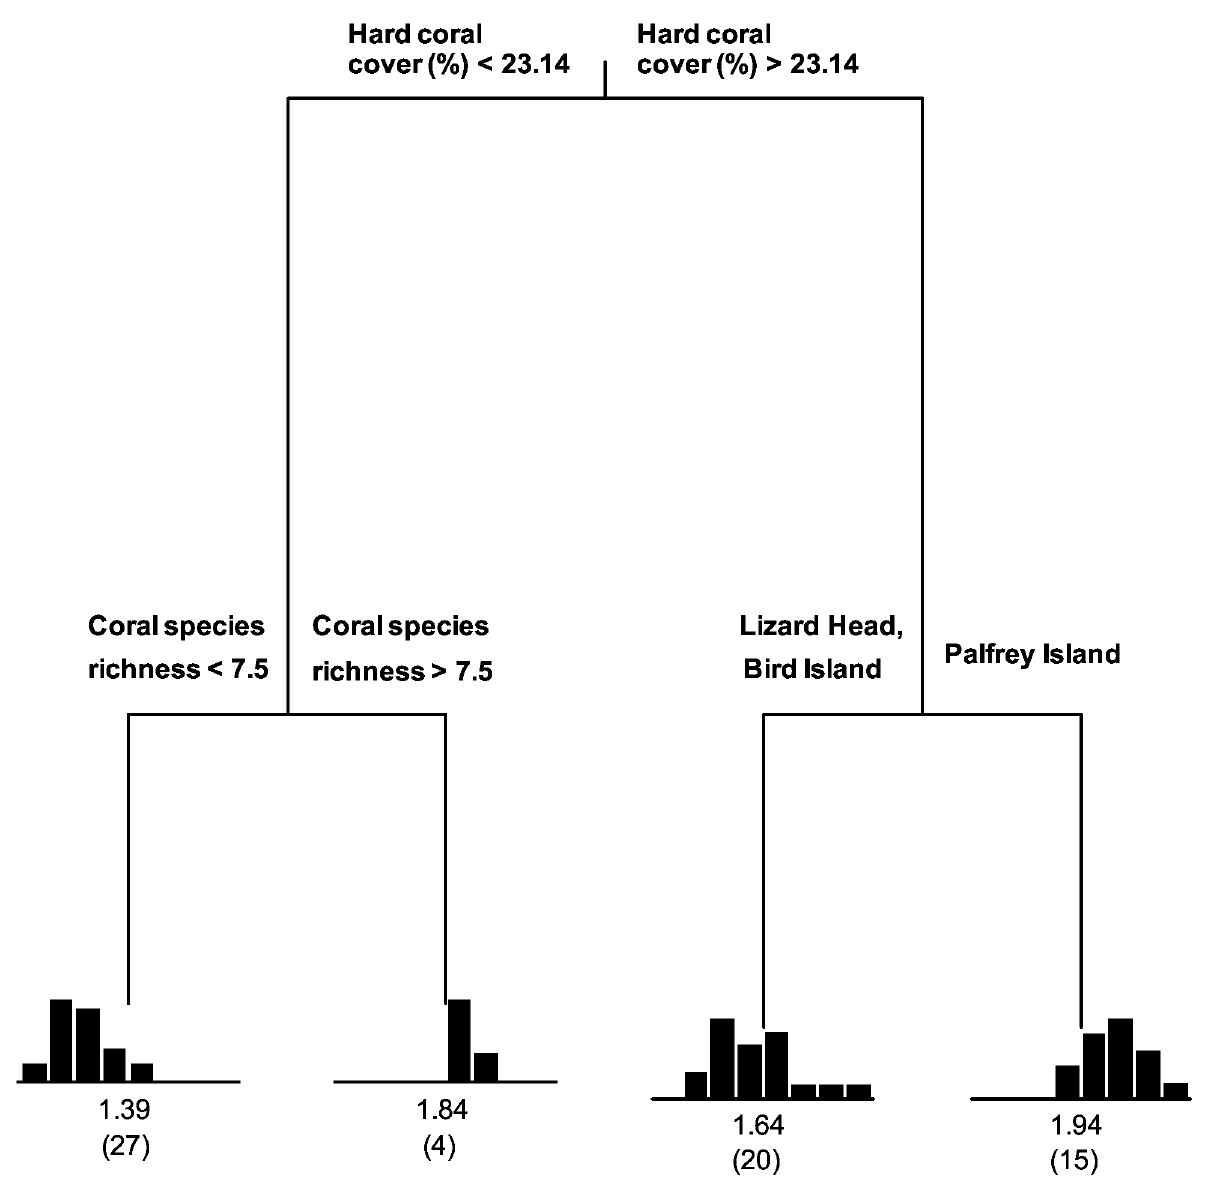
Figure 5. Regression tree analysis of the log fish abundance at Lizard Island, QLD, Australia. The explanatory variables were: site, topographic complexity, habitat diversity, coral species richness, coral diversity, percent hard coral cover, branching coral cover and plate coral cover. For each of the four terminal nodes the distribution of the observed values of log fish abundance is shown in a histogram. Each node is labeled with the mean rating and the number of observations in a group (in parentheses). The tree explained 34.1% of the total variability in the data. The first split based on percent hard coral cover explained 17.4%, second split based on coral species richness explained 8.1% and the third split based on site explained additional 8.6%. doi: